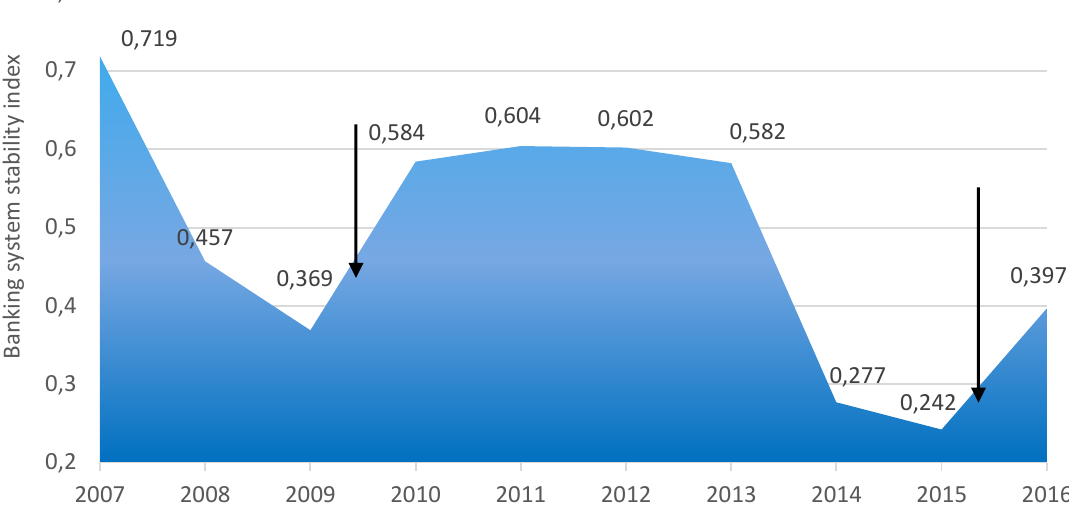
Figure 2. Dynamics of changes in the stability